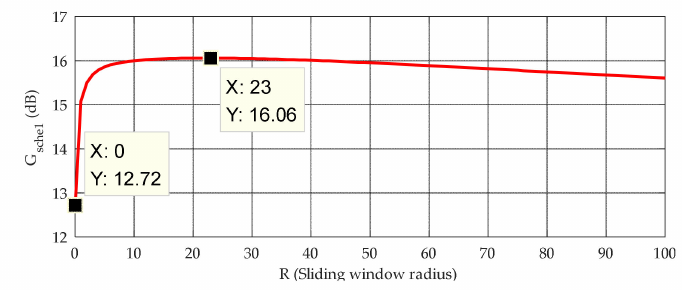
Figure 4. Relationship between G sche 1 and R in the case of SNR in = 0